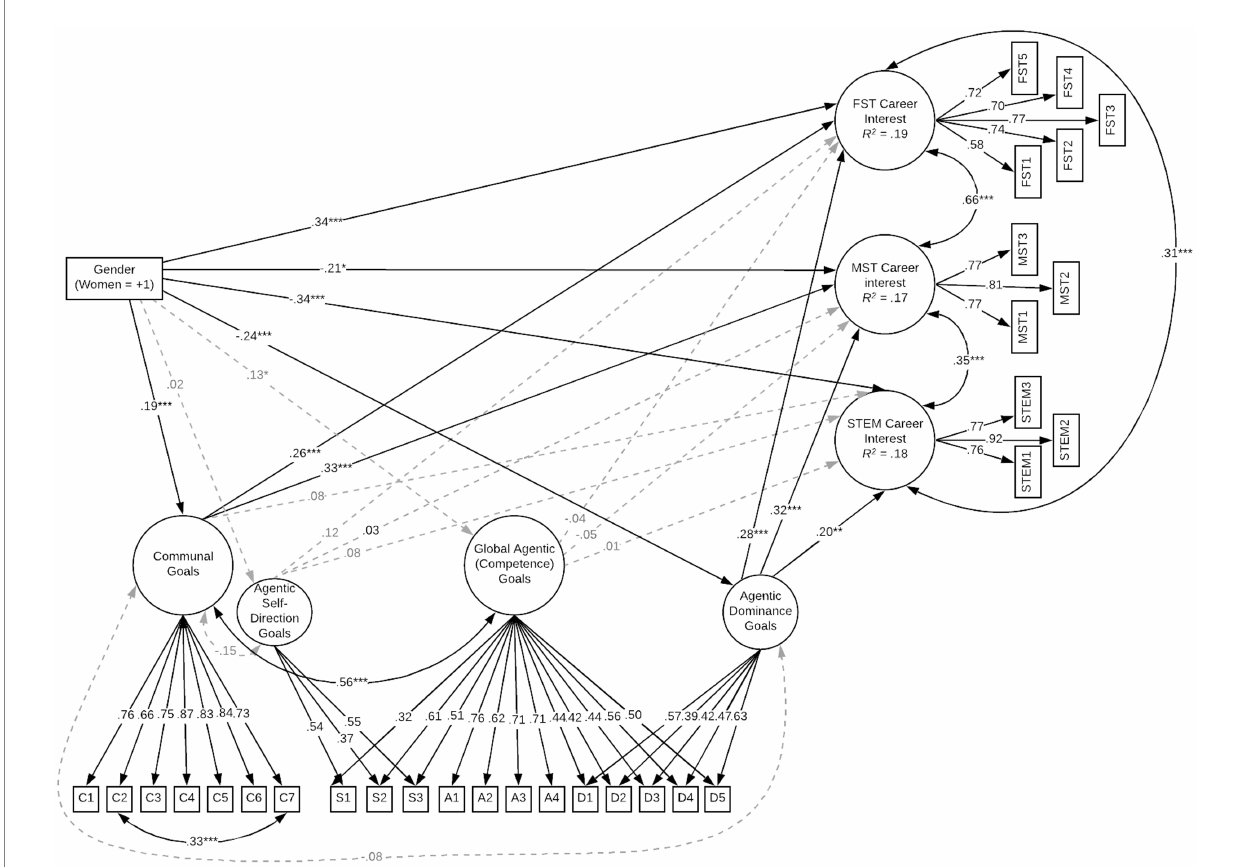
FIGURE 1 Structural bifactor model showing the relationships of gender to career interests via goal orientations. Direct effects of gender are denoted with Cohen’s d ; all other estimates are standardized. MST, male stereotypic venture. FST, female stereotypic venture. Indirect effects indicate that dominance goal orientations explained men’s interest in MST, β = − 0.08, p = 0.013, FST, β = − 0.08, p = 0.006, and STEM ventures, β = − 0.05, p = 0.04. In contrast, communal goal orientations explained women’s greater interest in FST ventures, β = 0.05, p = 0.032.